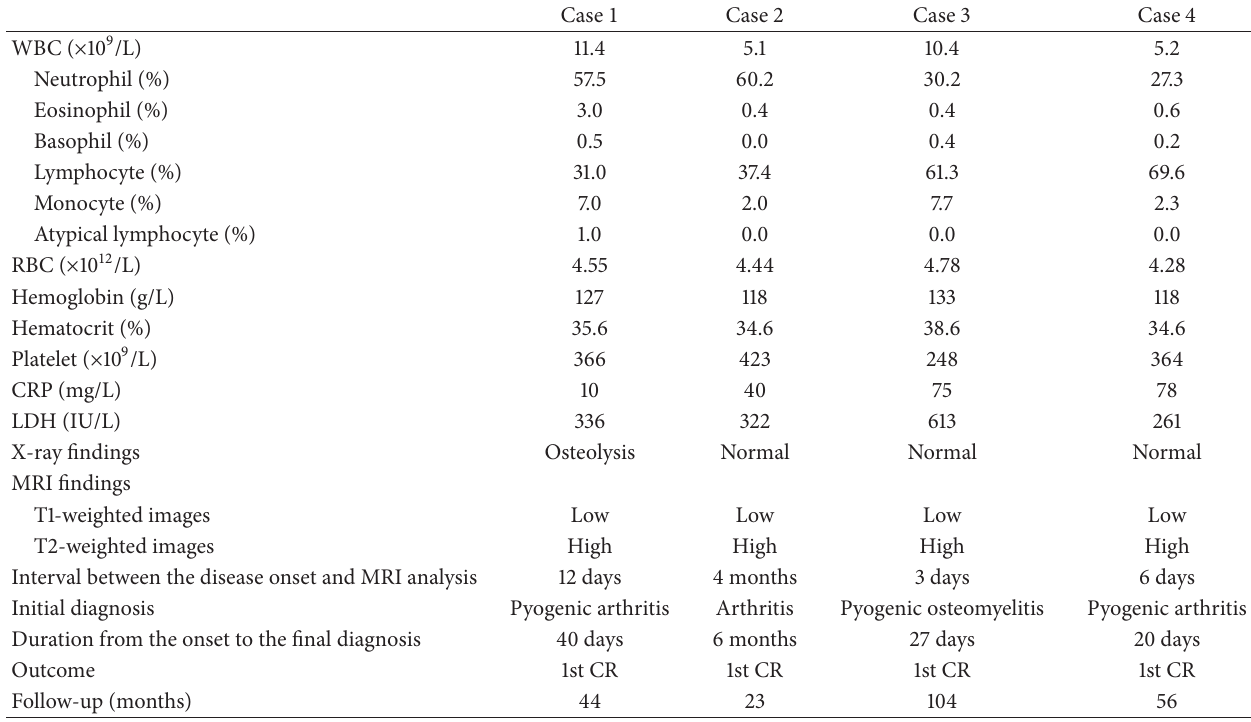
Table 1: Clinical characteristics of